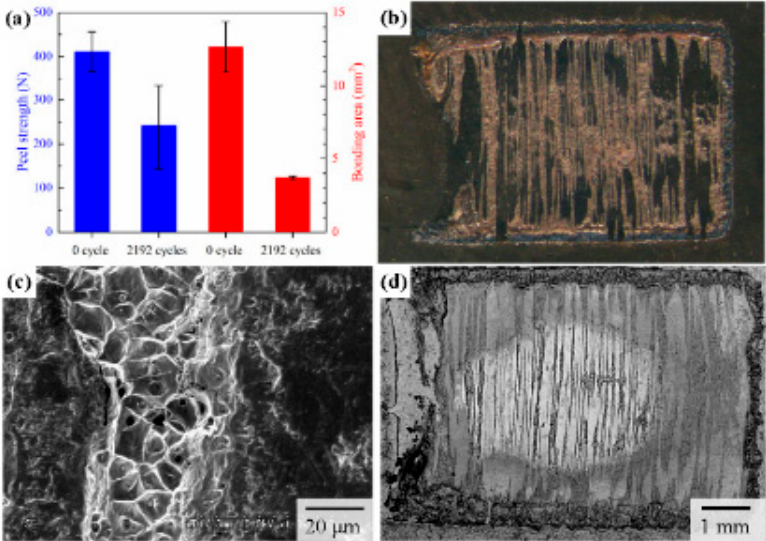
Figure 4. Measurement results of the peel strength and bonding area of the C1020 joints before and after the thermal cycling test. ( a ) Results of peel strength and bonding area. ( b ) Representative stereomicroscope image of the fractured surface. ( c ) SEM image of the boundary of a stripe. ( d ) Representative backscattered electron (BSE) image of the fractured surface after thermal cycling tests.